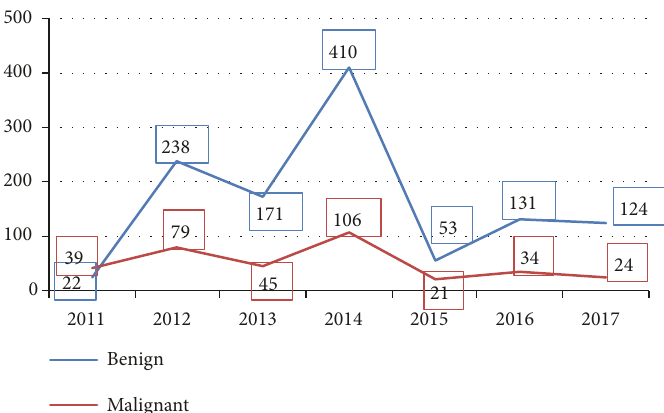
Figure 3: Distribution of Incidence over seven years by malignant and benign tumor cases.